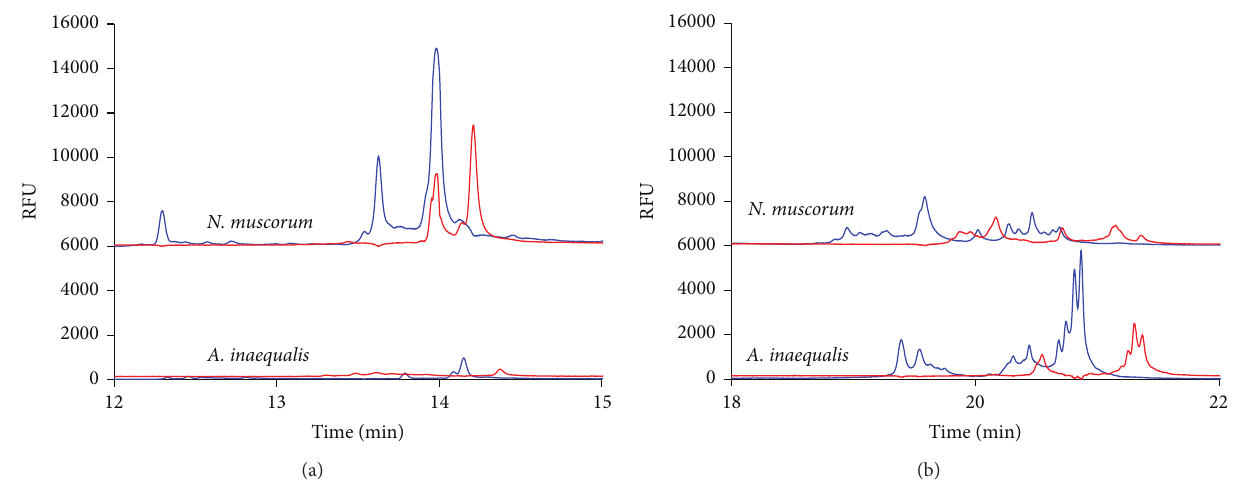
Figure 1: Detection of the (a) early and (b) later migrating peaks formed from the 16S rDNA gene variable region 2 as detected by CE-SSCP for the cyanobacteria (prokaryotic) N. muscorum and A. inaequalis